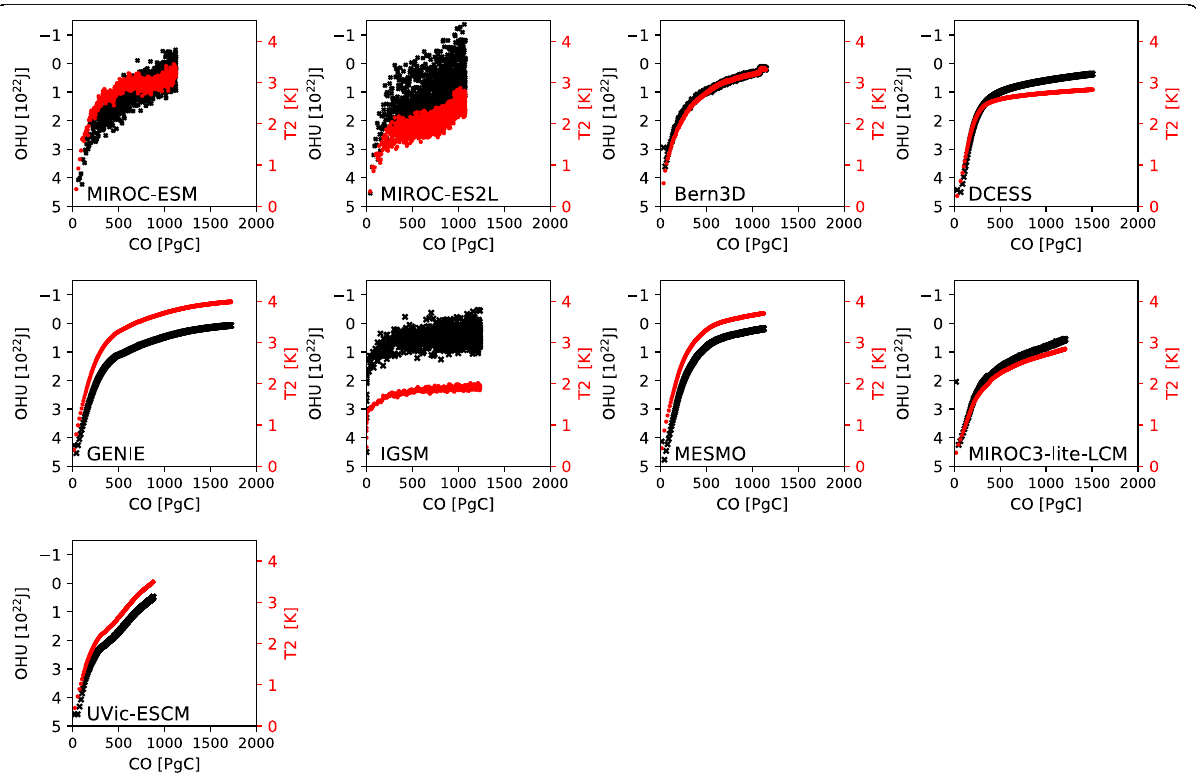
Fig. 6 The relationship between cumulative oceanic carbon uptake (CO) and (1) changes in global mean air temperature (red dots, T2) and (2) annual ocean heat uptake (black dots, OHU) in the experiments of abruptly doubled CO 2 concentration during 1000 years by two ESMs (MIROC- ESM and MIROC-ES2L) and seven EMICs from EMIC-AR5. The UMD model shown in Fig. 5 was omitted because the data on ocean heat uptake of the model was not